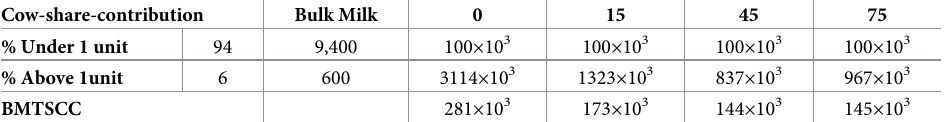
Table 3. Theoretical calculation of BMTSCC based on the results of the APT treatment impact of the higher share-contributing cows.